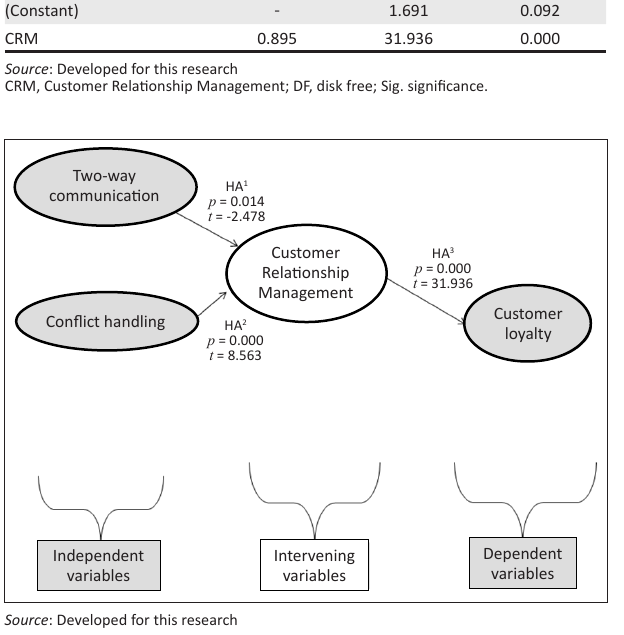
FIGURE 2: Empirical framework modified.